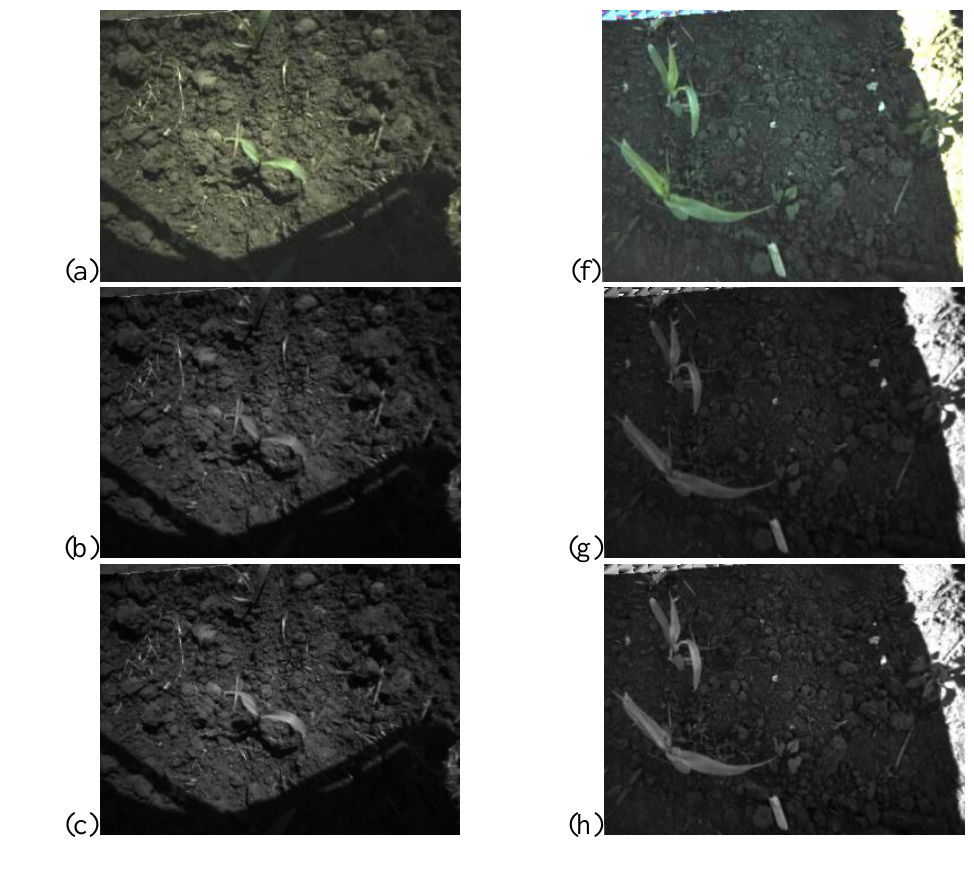
Figure 2. An example of original, red-, green-, blue-channel and normalized excessive green images. ( a ) Field image captured in the morning. ( b ) Red channel of the morning image. ( c ) Green channel of the morning image. ( d ) Blue channel of the morning image. ( e ) Normalized excessive-green image of the morning image. ( f ) Field image captured in the afternoon ( g ) Red channel of the afternoon image. ( h ) Green channel of the afternoon image. ( i ) Blue channel of the afternoon image. ( j ) Normalized excessive-green image of the afternoon